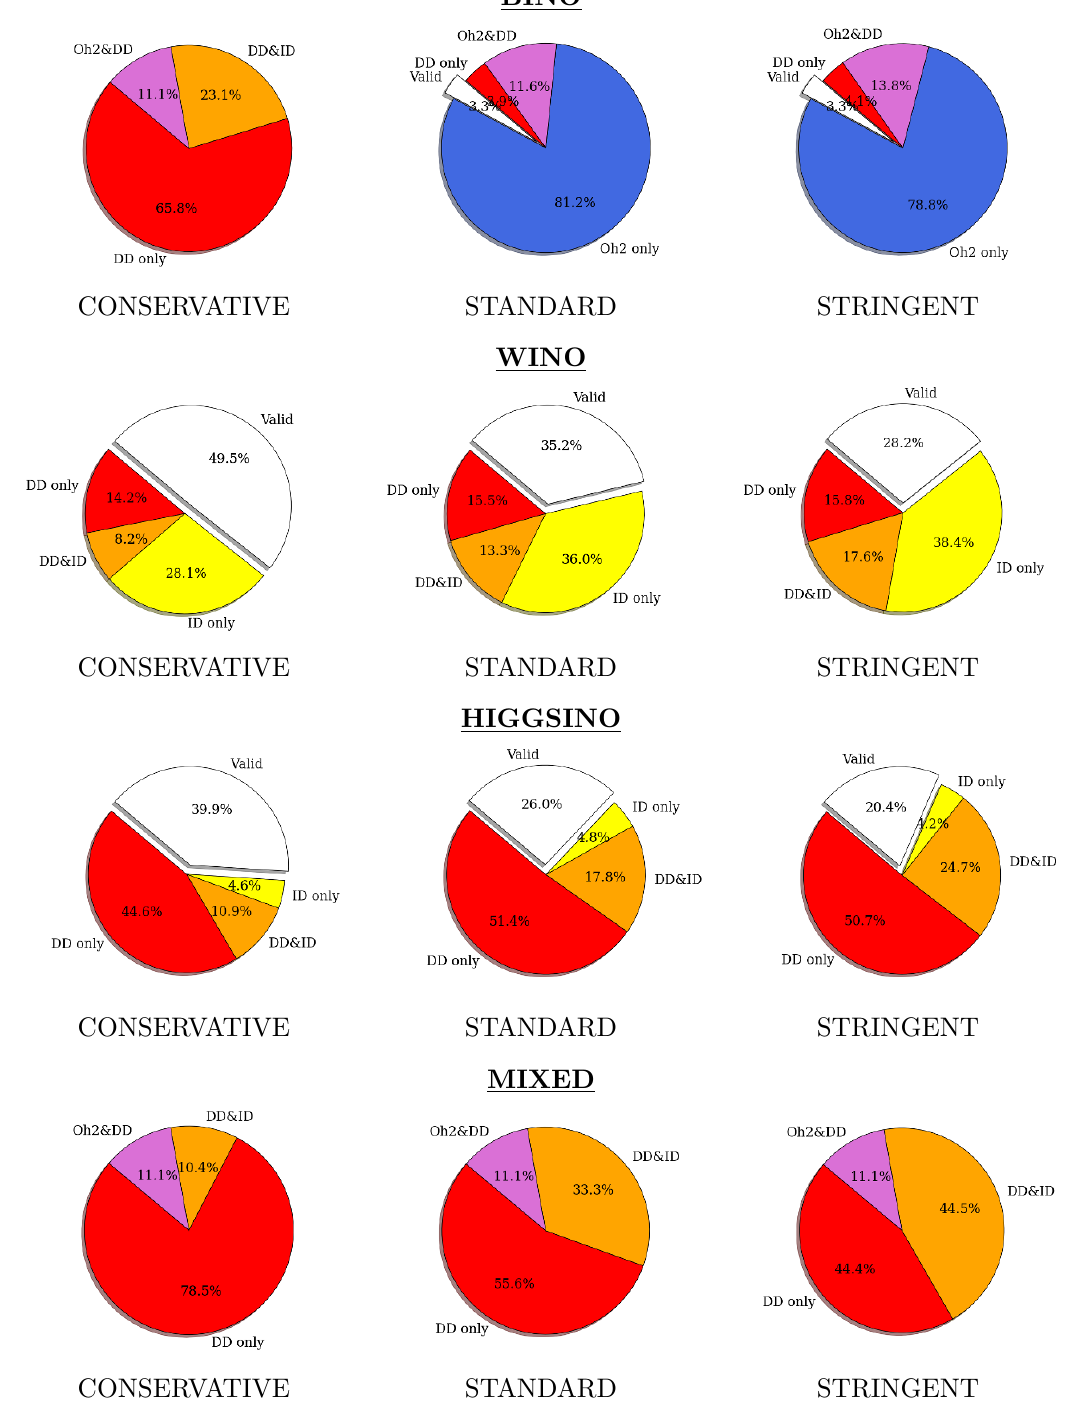
Figure 15 . Fraction of pMSSM points excluded by the upper bound of the dark matter density, direct detection and indirect detection constraints for the di(cid:11)erent neutralino 1